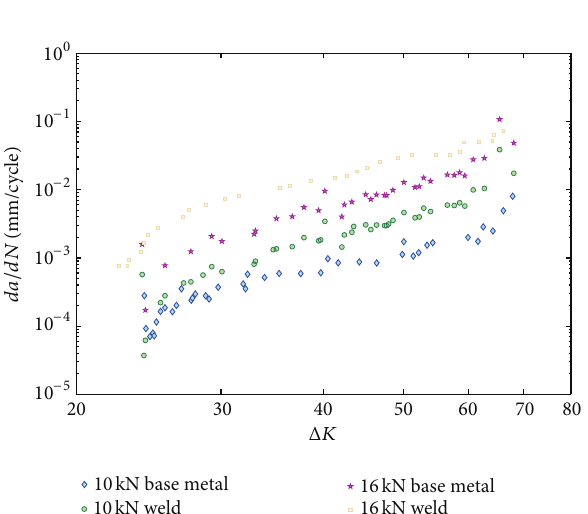
Figure 3: Relationships between crack growth rates and stress intensity factor range.